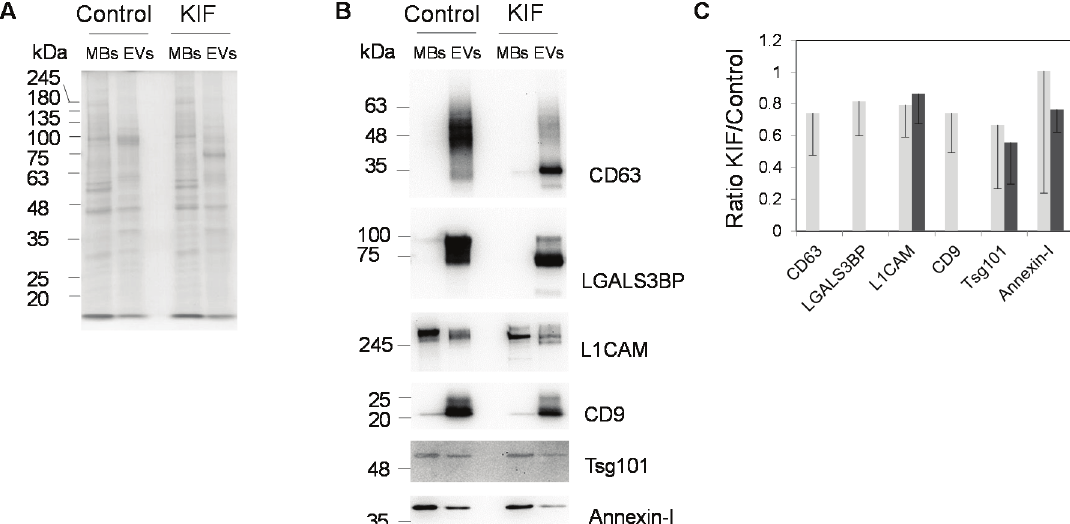
Figure 5. Effect of kifunensin on the protein profiles from MBs and EVs. ( A ) SDS-PAGE analysis. Protein staining was with Coomassie Blue-R250. Five μg of protein were applied per lane. KIF was used at 5 μM concentration; ( B ) Immunoblot analysis. Three μg of total protein were applied per lane; ( C ) Semi-quantitative analysis of the ratio between band intensities in the presence or absence of KIF using Image J software. Representative blots ( B ) average and standard deviation ( C ) from six experiments are presented. Light and dark grey corresponded to EVs and MBs,